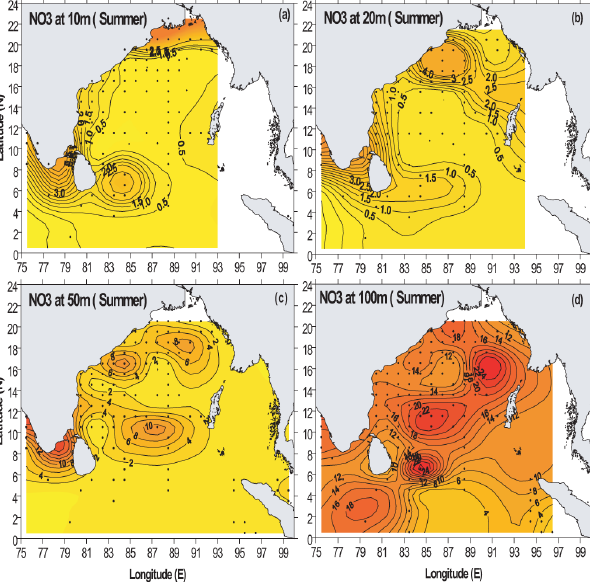
Figure 11. Spatial distribution of chlorophyll a (mgm − 3 ) at (a) 10, (b) 20, (c) 50, and (d) 100m during spring intermonsoon.